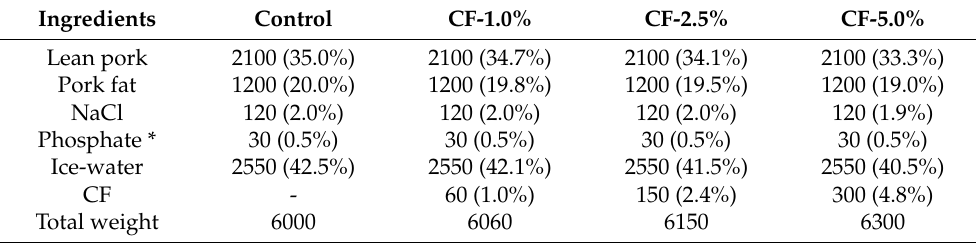
Table 1. Ingredient amounts (g) of the formulated sausages with lean pork, pork fat, and cricket flour.